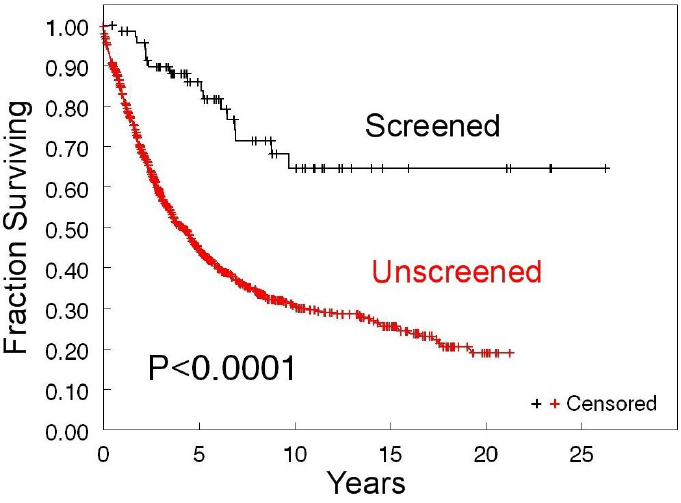
Figure 2. Kaplan–Meier disease-specific survival of screened and unscreened women with epithelial ovarian cancer by method. Vertical lines indicate censored points.